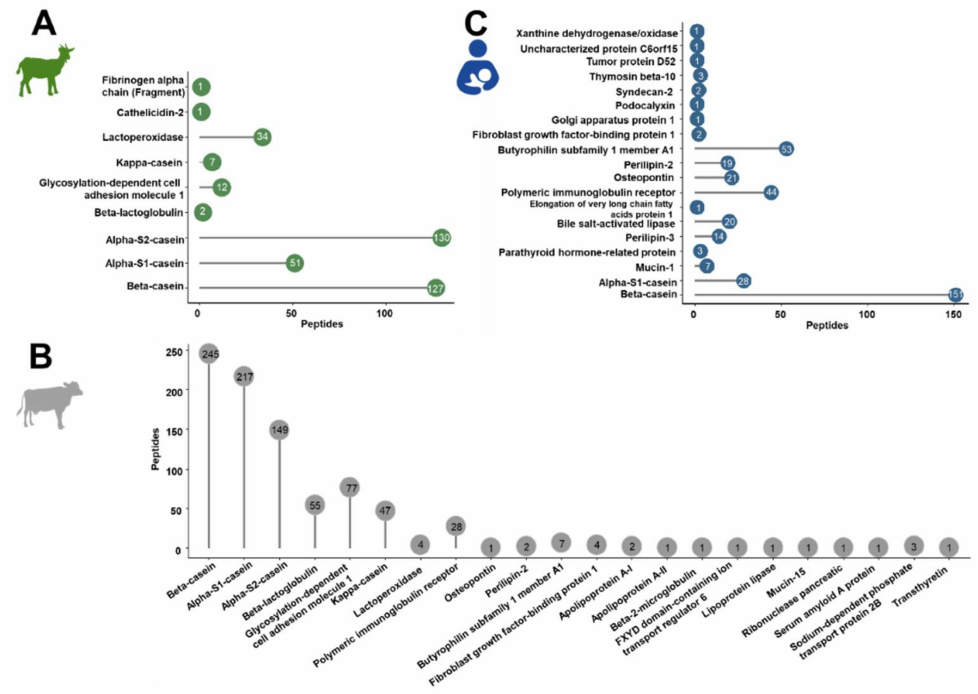
Figure 1. Overall number of peptides identified for each source protein in goat ( A ) and cow milk- based IF ( B ) and in human milk ( C